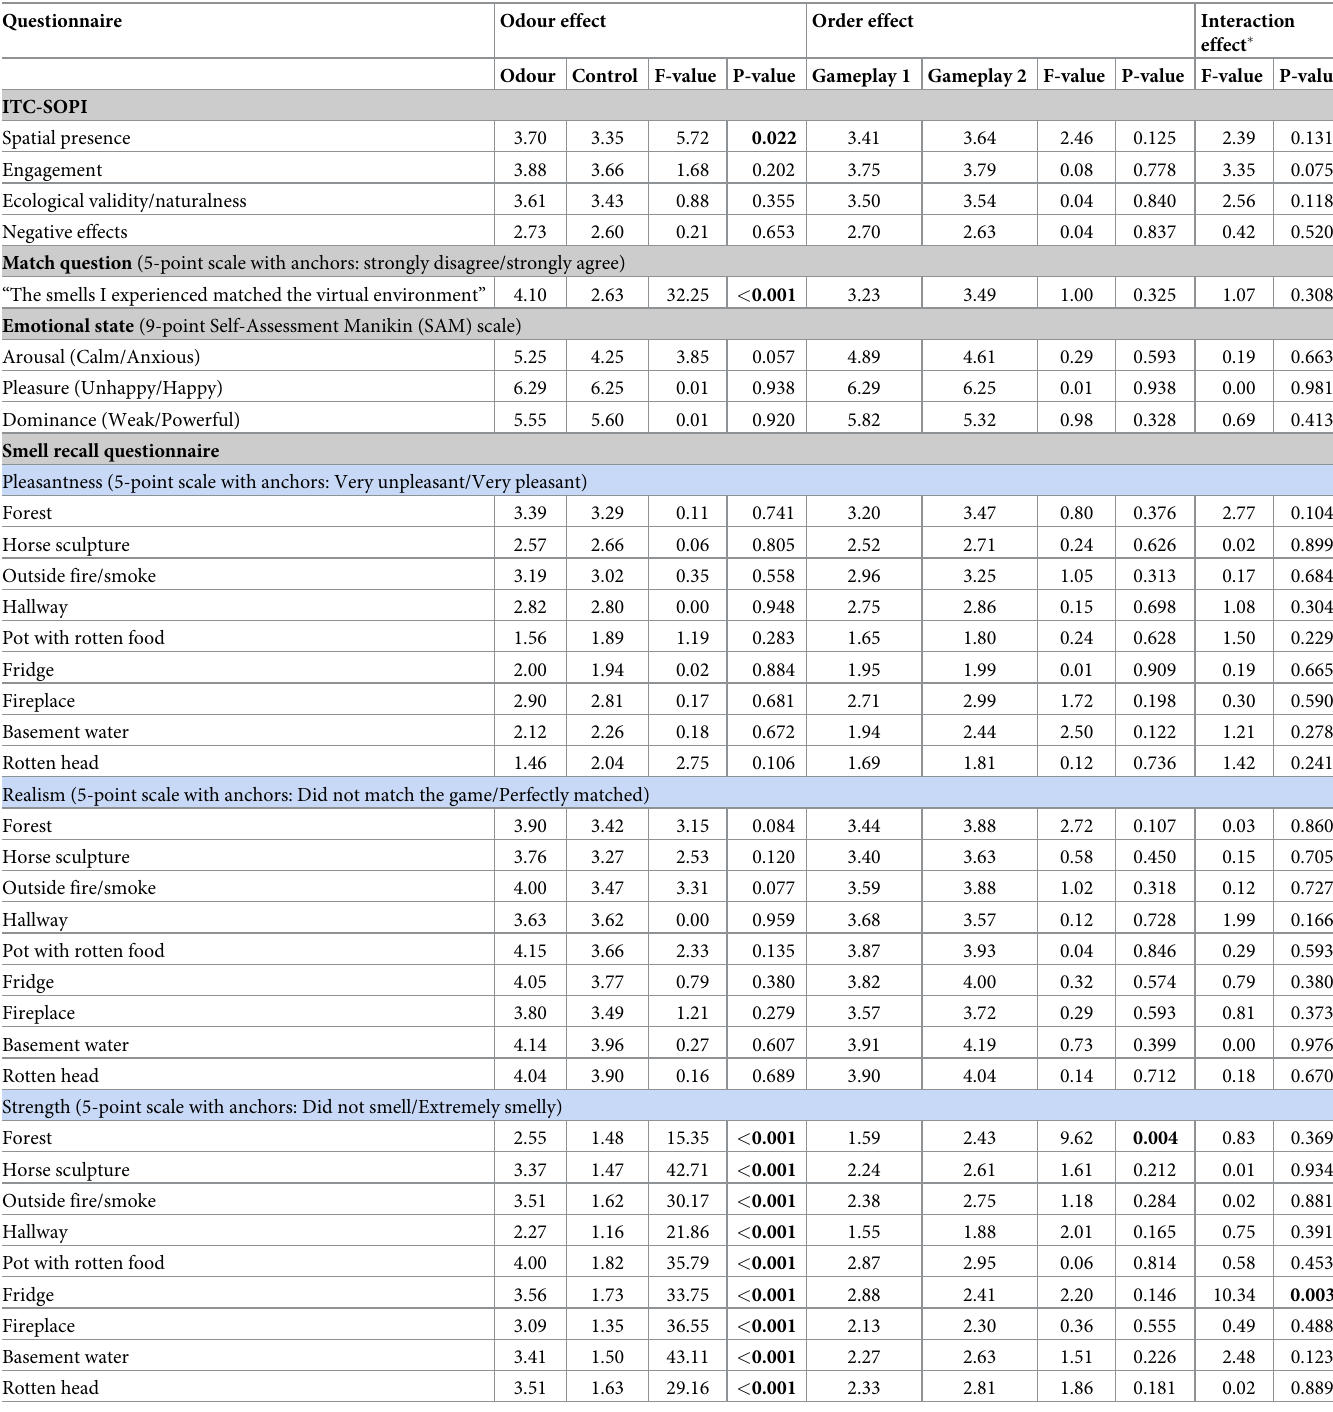
Interaction effect assessed Odour � Order interaction. Bold values highlight significant